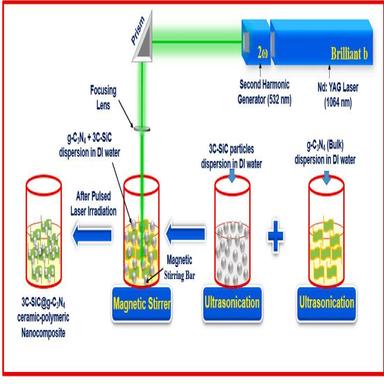
Schematic diagram for the synthesis of ceramic-polymeric 3C–SiC@g-C3N4 nanocomposite using pulsed laser ablation in liquid (PLAL) technique.